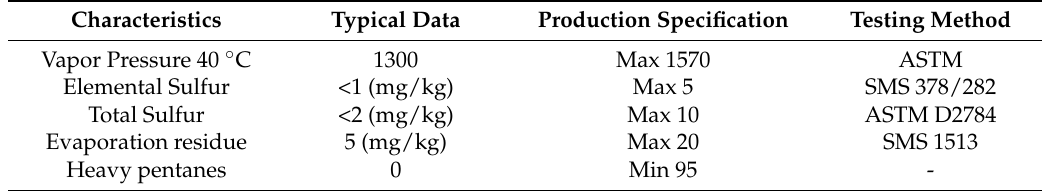
Table 1. Propane properties.